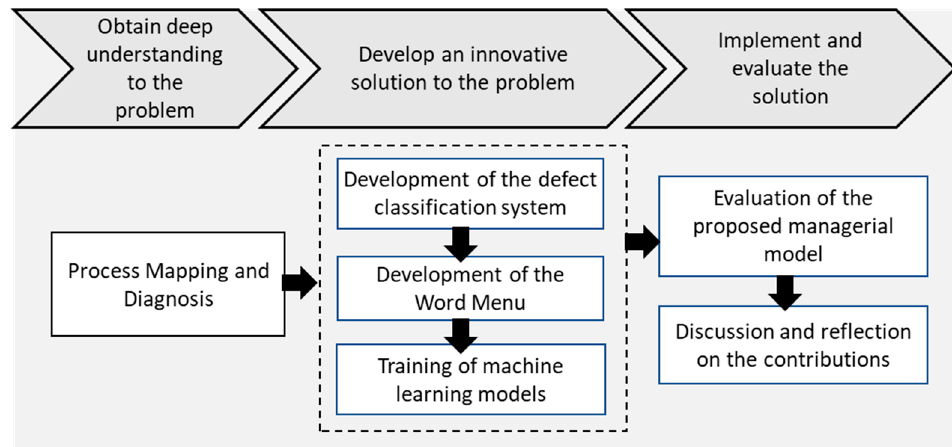
Figure 1. Research design.